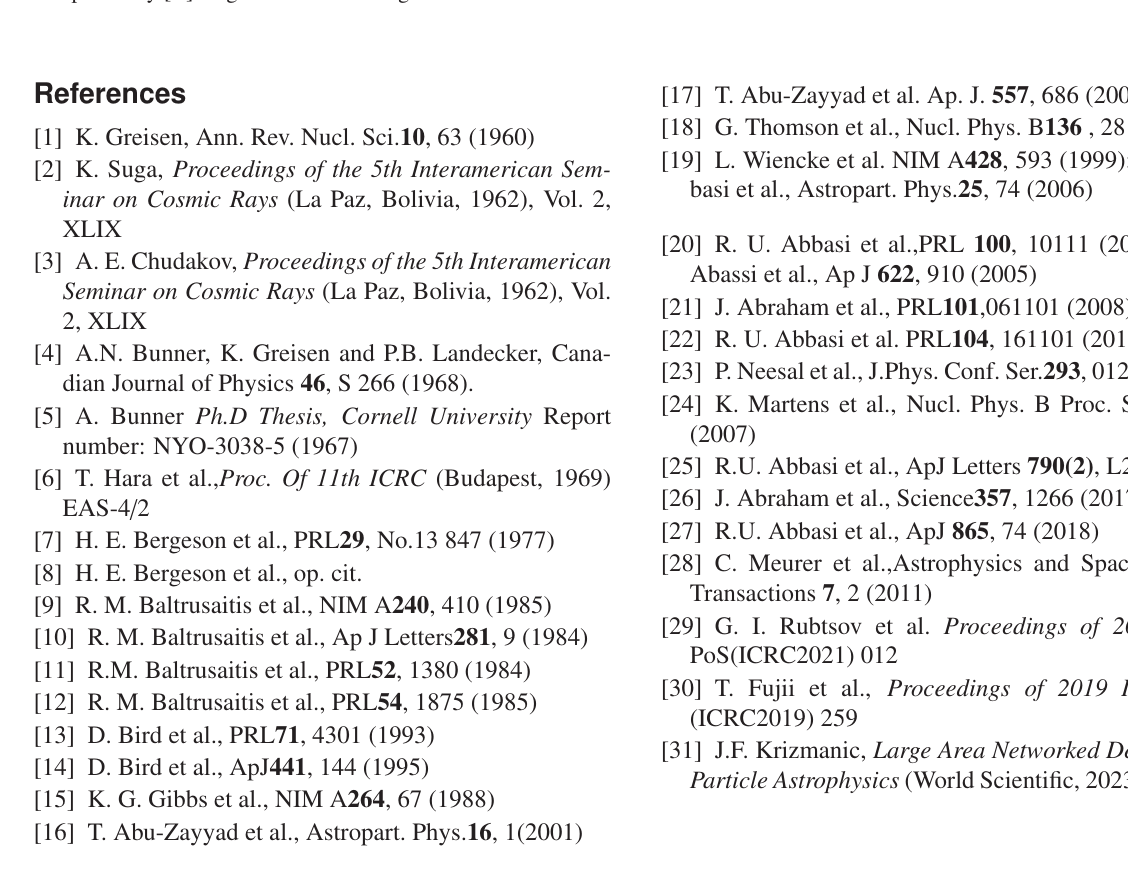
Figure 10. [Top L] BR air-fluorescence detector station for TA, [Top R] Middle Drum detector station for TA; Bottom [L] Auger mirror and pmt array [R] Auger detector